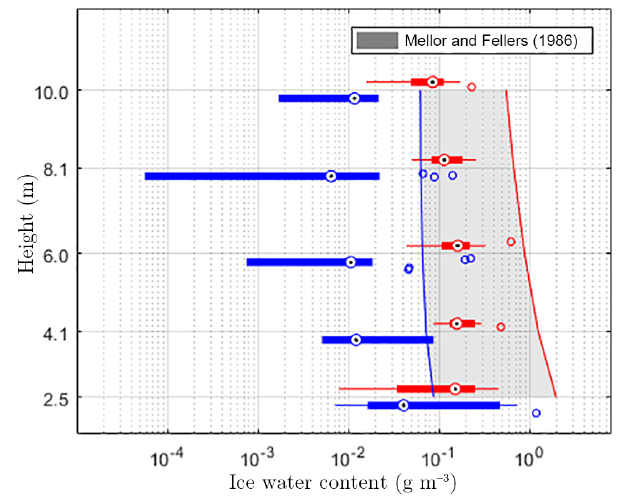
Figure 15. Comparison of the height dependence of the ice water content for the time intervals between 12:00 and 15:00UTC (red box plots) and 19:10 and 20:20UTC (blue box plots) using the blowing snow parameterization of Mellor and Fellers (1986). The wind speed in the time interval between 12:00 and 15:00UTC was around 20ms − 1 and between 19:10 and 20:20 around 10ms − 1 . The gray shaded area indicates the calculated ice water content from the parameterization for wind speeds between 10 (blue line) and 20ms − 1 (red